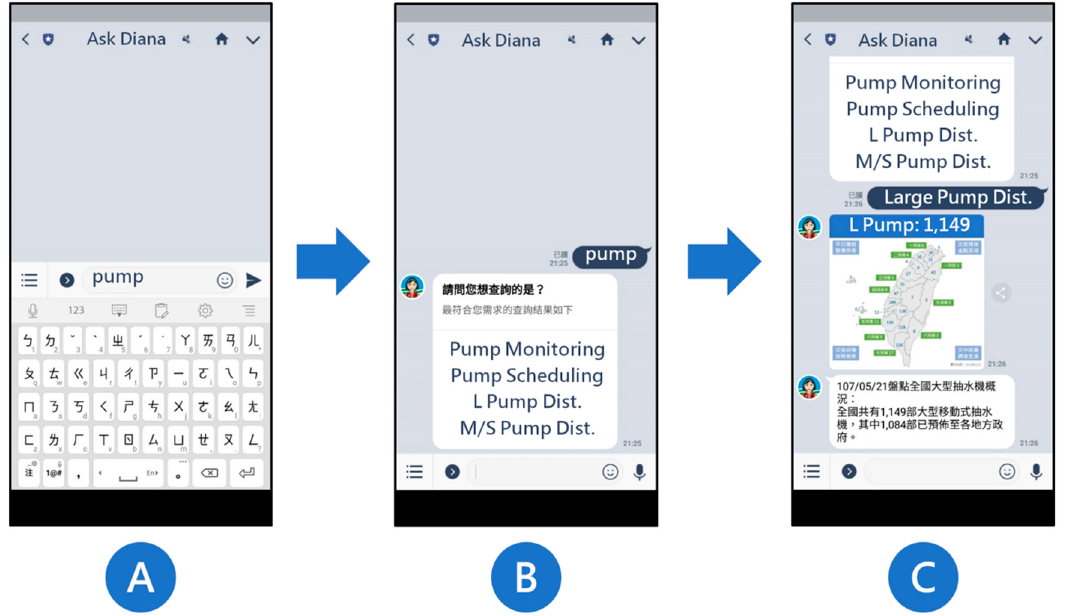
Figure 5. Access the data through input keywords: ( A ) Input keywords using LINE; ( B ) Ask Diana provides the top four suitable data for users to choose from; and ( C ) Ask Diana provides the related data to the user.